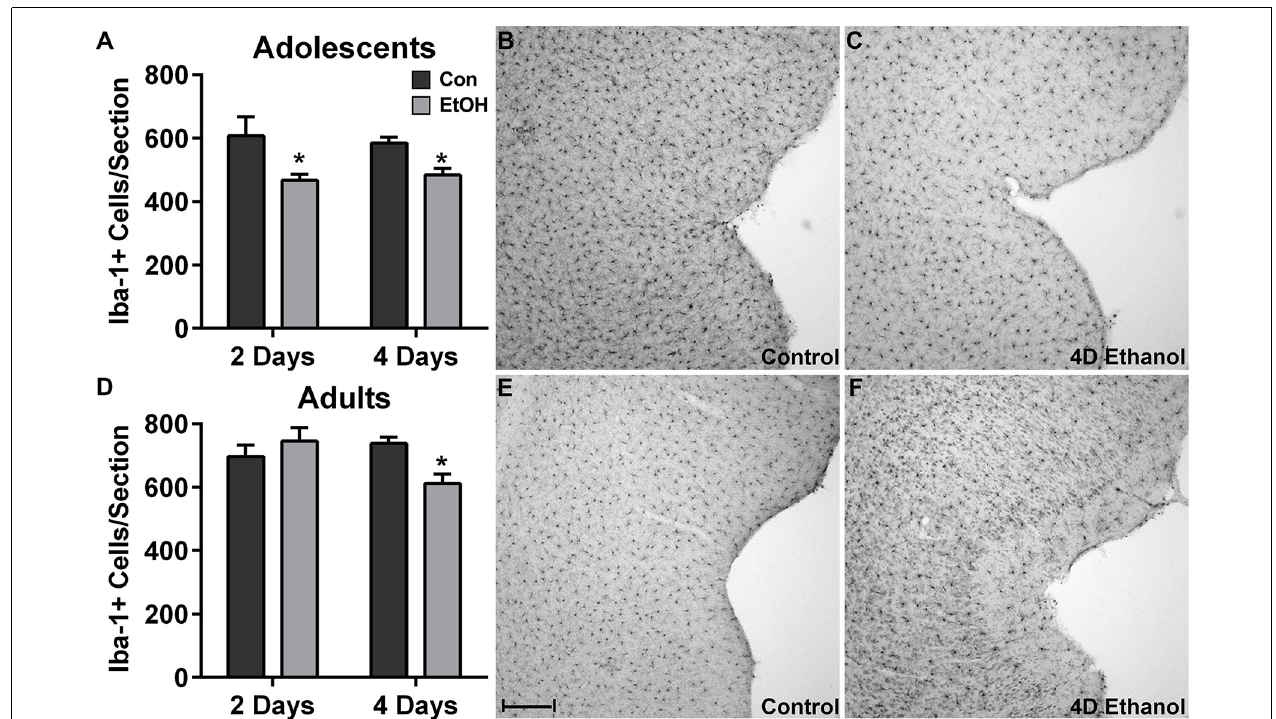
FIGURE 2 | Ethanol decreases microglia numbers in the peri-entorhinal cortex. In the peri-entorhinal cortex, post hoc tests indicated a reduced number of microglia after both 2 and 4 days of ethanol exposure vs. controls in adolescents (A) while the loss of microglia occurred after only 4-days of ethanol exposure in adults (D) . Representative photomicrographs of the entorhinal cortex of adolescent (B) and adult (E) control-treated animals have significantly more microglia compared with the photomicrographs of the alcohol-treated corresponding adolescent (C) or adult (F) images. Data are mean ± SEM. Scale bar = 200 µ m, * p < 0.05.